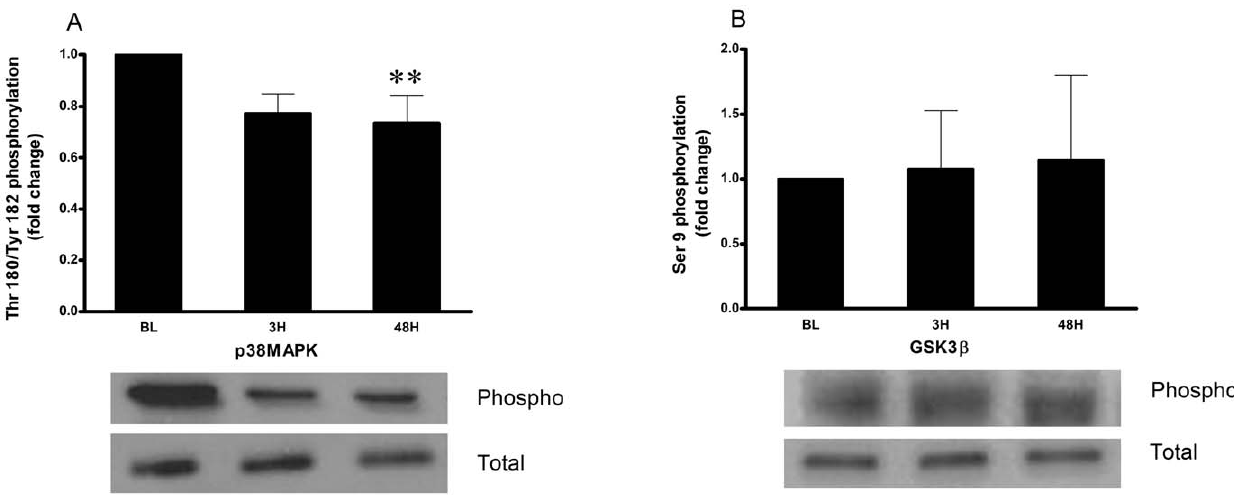
Figure 3. Fold change of phosphorylated/total ratio of signaling pathways from baseline after eccentric exercise. BL = baseline, 3H = 3 hours post exercise, 48H=48 hours post exercise. Graph A – p38MAPK (Thr 180 /Tyr 182 ) (N=18). Graph B – GSK-3 b (Ser 9 ) (N=18). Values are mean 6 SEM. **Significant difference vs. baseline when collapsed across supplementation (P , 0.01).